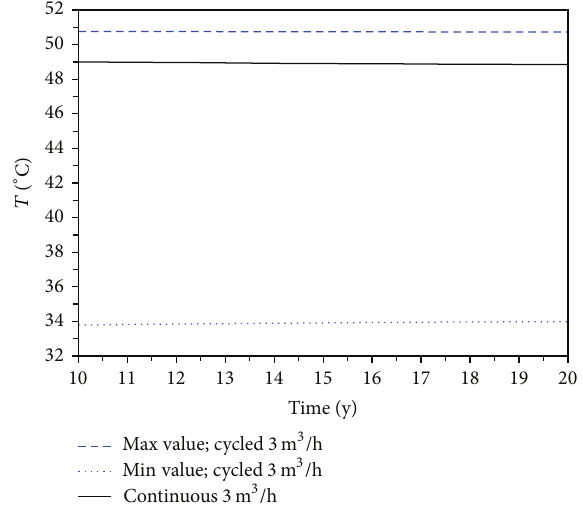
Figure 13: The maximum and minimum temperatures of a cyclic and a continuous flow rate of 3m 3 /h each during a time period between 10 and 20 years of